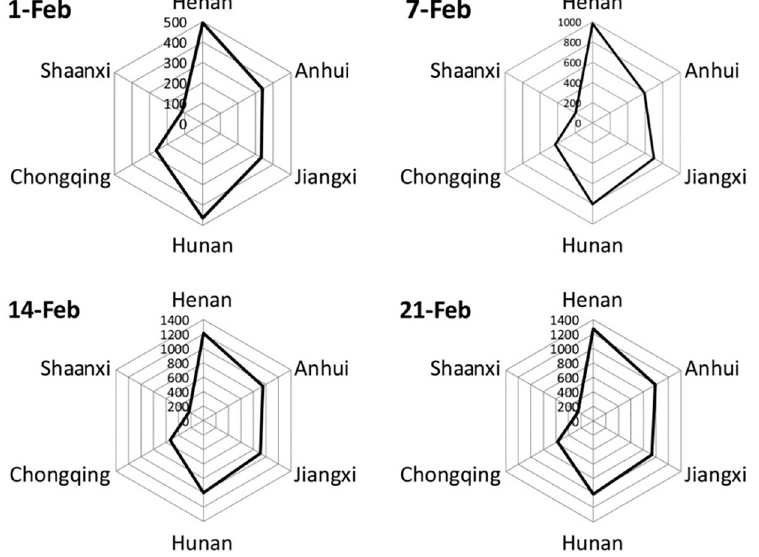
Fig 4. The spatial variability of NCCC of COVID-19 in 6 provinces from February 1 to 21. (figure was drawn by author).